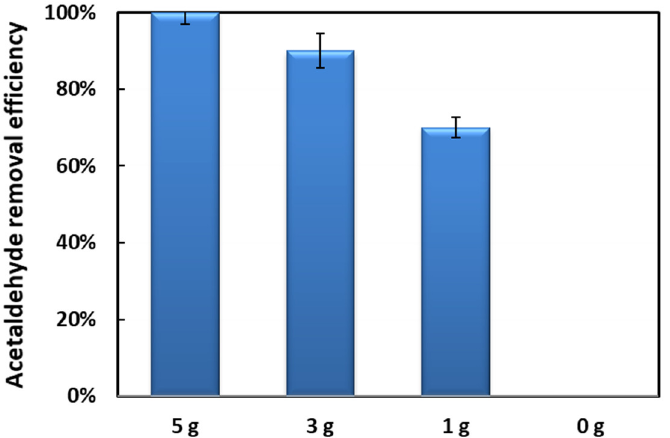
Figure 4. The effect of amount of catalysts (10 wt.% Mn/NZ) on the acetaldehyde oxidation in relative humidity 60%.